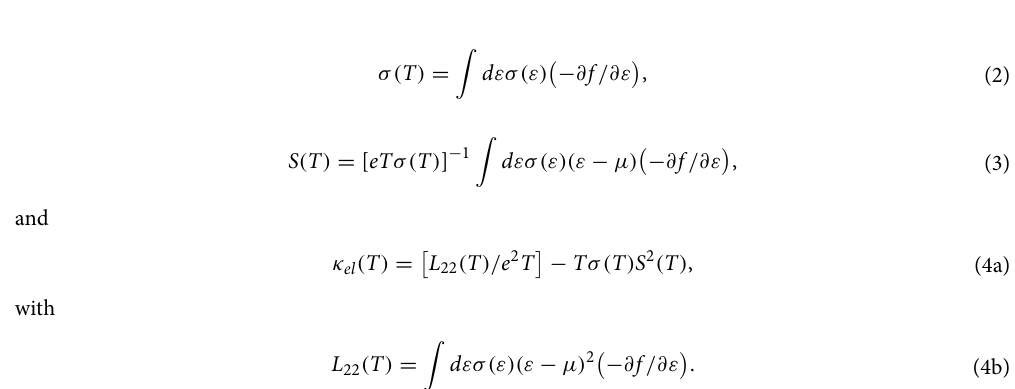
Figure 5. Magnetic susceptibility χ = M / H of the HEA and MG samples in magnetic fields 1, 3, 5 and 7 T (for each sample, the curves in different fields are indistinguishable on the graph, except in the T → 0 limit). The inset shows the isothermal magnetization curves, M ( H ) , at 300